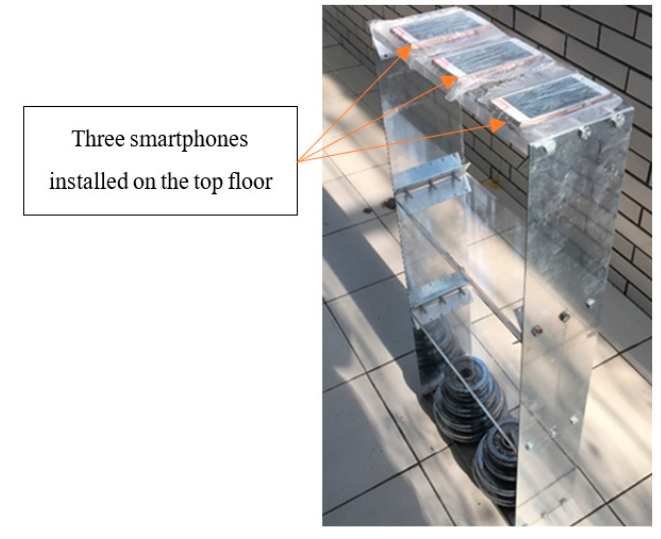
Figure 9. Time synchronization experimental setup.